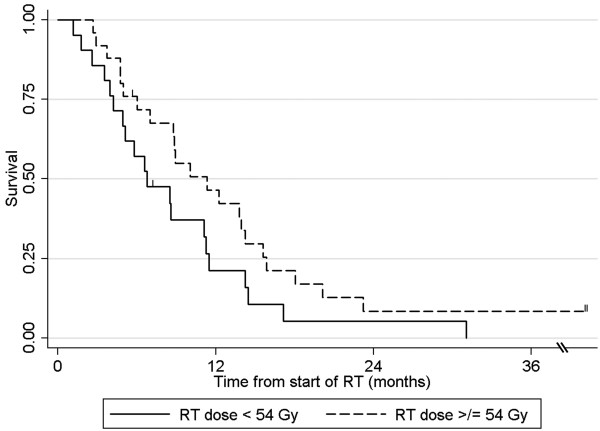
Overall survival for patients treated with < or ≥ 54 Gy of radiotherapy. Note: two long term survivors are censored at 58 and 88 months.